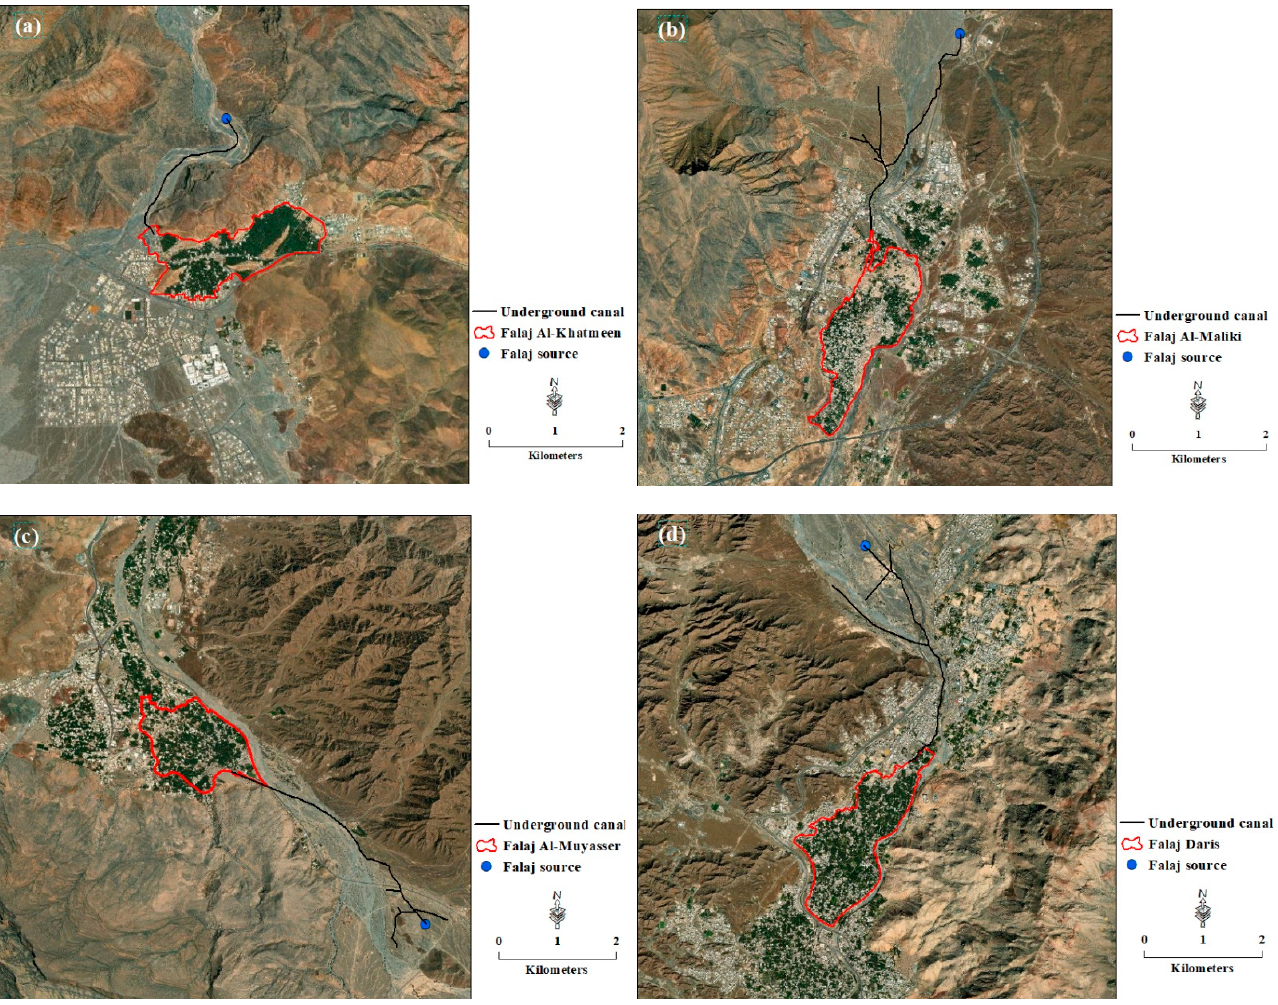
Figure 3. LULC case studies of a drawing of ( a ) Falaj Al-Khatmeen, ( b ) Falaj Al-Maliki, ( c ) Falaj Al- Muyasser, and ( d ) Falaj Daris, including the aflaj sources, underground canal, and the area irrigated by the falaj.